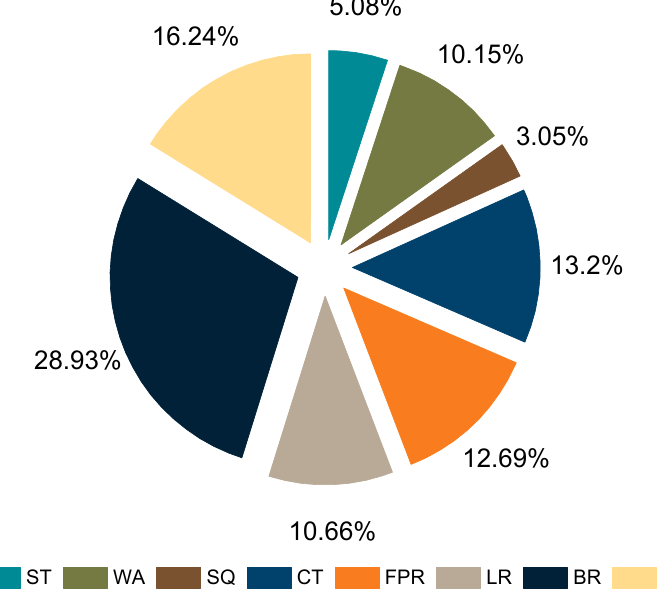
Figure 11. Time ratio of construction workers’ activities.